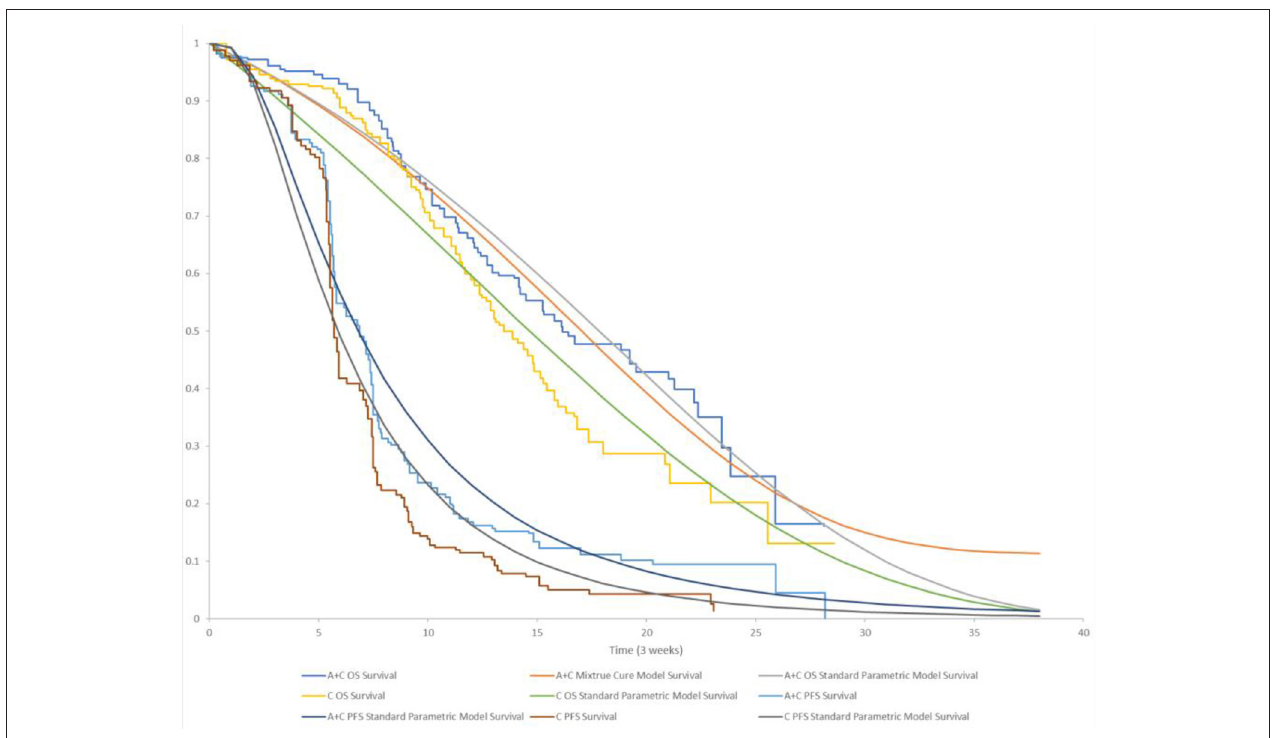
FIGURE 2 | KM and parametric survival distributions for OS and PFS. A + C, atezolizumab + chemotherapy; C,